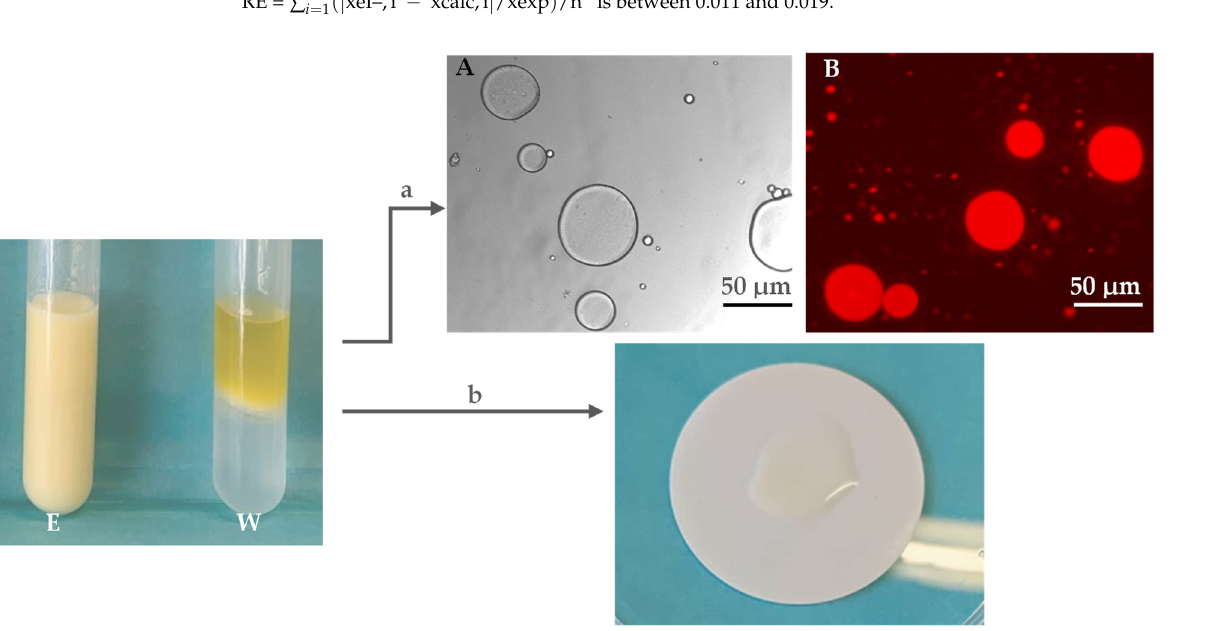
Figure 6. (a) Optical microscopic (40 × ) images of olive oil/d-FucoPol emulsion (E) (o:w weight ratio of 2:3); contrast phase and fluorescence after Nile Blue A staining ( A , B , respectively). (b) Filter paper wetting test for emulsion type determination. (W)—blank sample, oil/water, and film obtained with deacylated form of